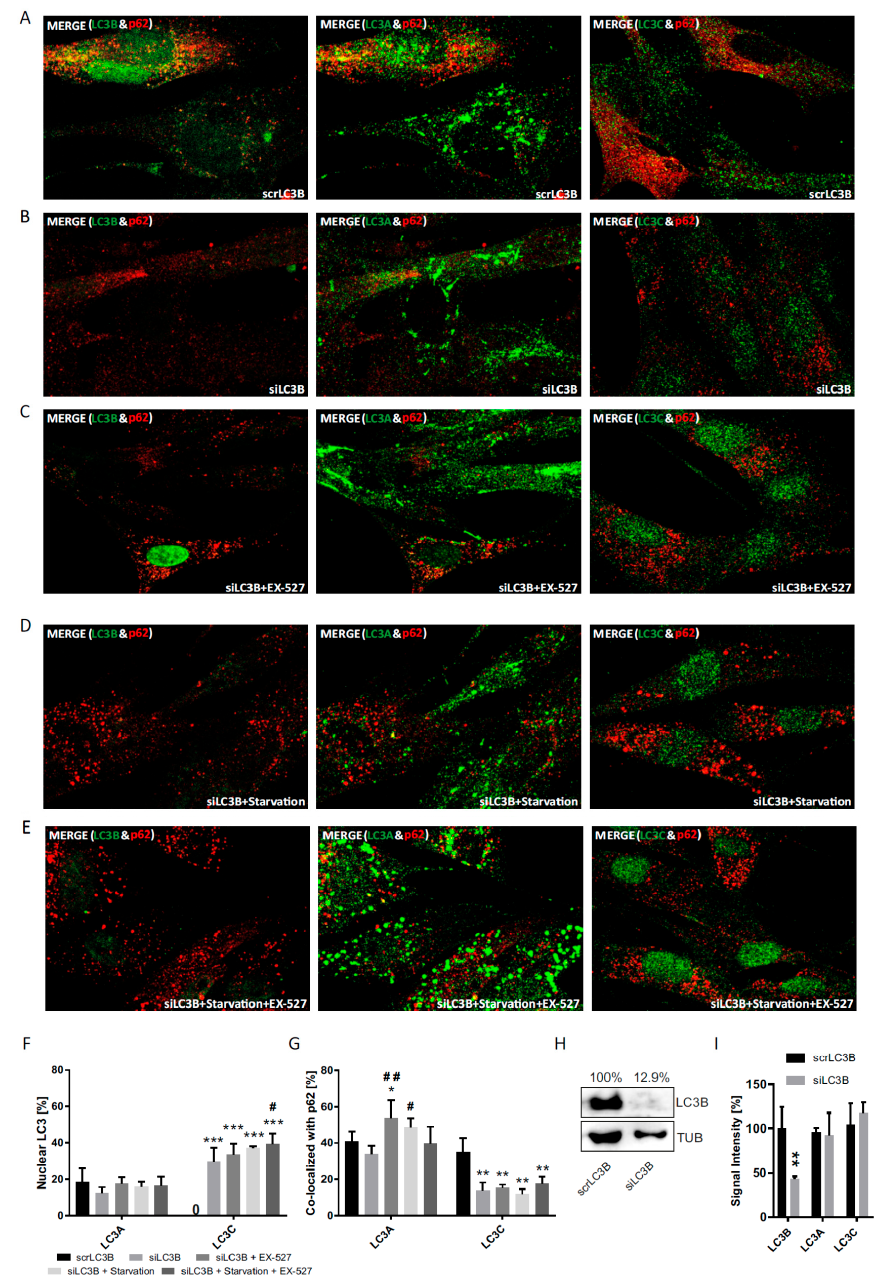
Figure 8. Analysis of the cellular localization of LC3A, LC3B, LC3C after siRNA-mediated LC3B knock-down. Primary human fibroblasts were treated with BafA1 after transfection with ( A ) scrLC3B-RNA, ( B ) siLC3B-RNA, ( C ) siLC3B-RNA and Ex527 treatment, ( D ) siLC3B-RNA and starvation, and ( E ) siLC3B-RNA and starvation and Ex527 treatment. ( F ) Quantification of the relative nuclear fraction of LC3A and LC3C in cells treated as indicated. ( G ) Relative co-localization of LC3A and LC3C with p62 quantified by image analysis. Significant changes (by two-way ANOVA) versus scrLC3B: * p ≤ 0.05; ** p ≤ 0.01; *** p ≤ 0.001; significant changes versus siLC3B: # p ≤ 0.05; ## p ≤ 0.01. ( H ) LC3B protein expression in cells transfected with scrLC3B-RNA or siLC3B-RNA. Tubulin was used as loading control. ( I ) Control of knock-down and antibody specificity under immunocytochemistry conditions. Whole-cell signal intensities were quantified and evaluated by two-way ANOVA. Data in ( F ), ( G ) and ( I ) were derived from three photographed, independent experiments ( n = 3), in which 12–45 cells per image were